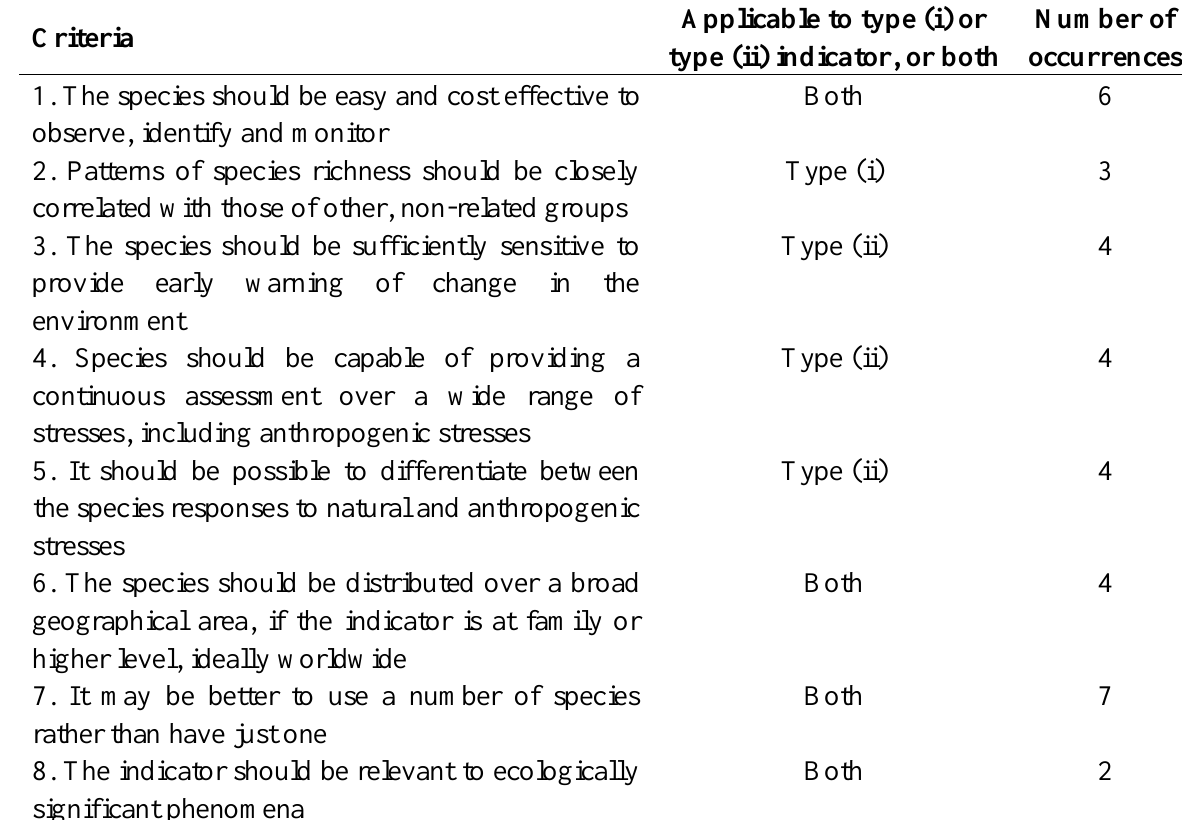
Table 1. Criteria for type (i) and type (ii) indicator